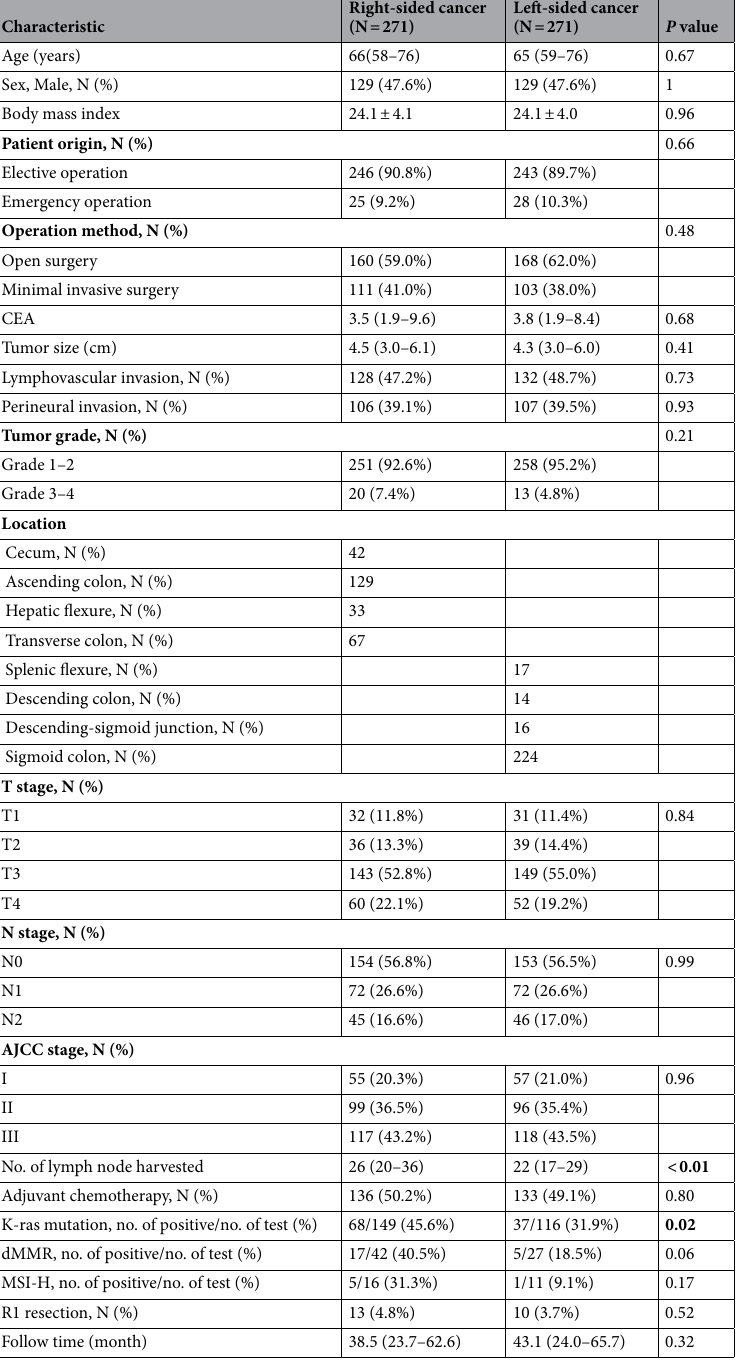
Table 4. Baseline characteristics after propensity score matching. Significant values are in bold. CEA carcinoembryonic antigen, dMMR Deficient mismatch repair, MSI-H microsatellite